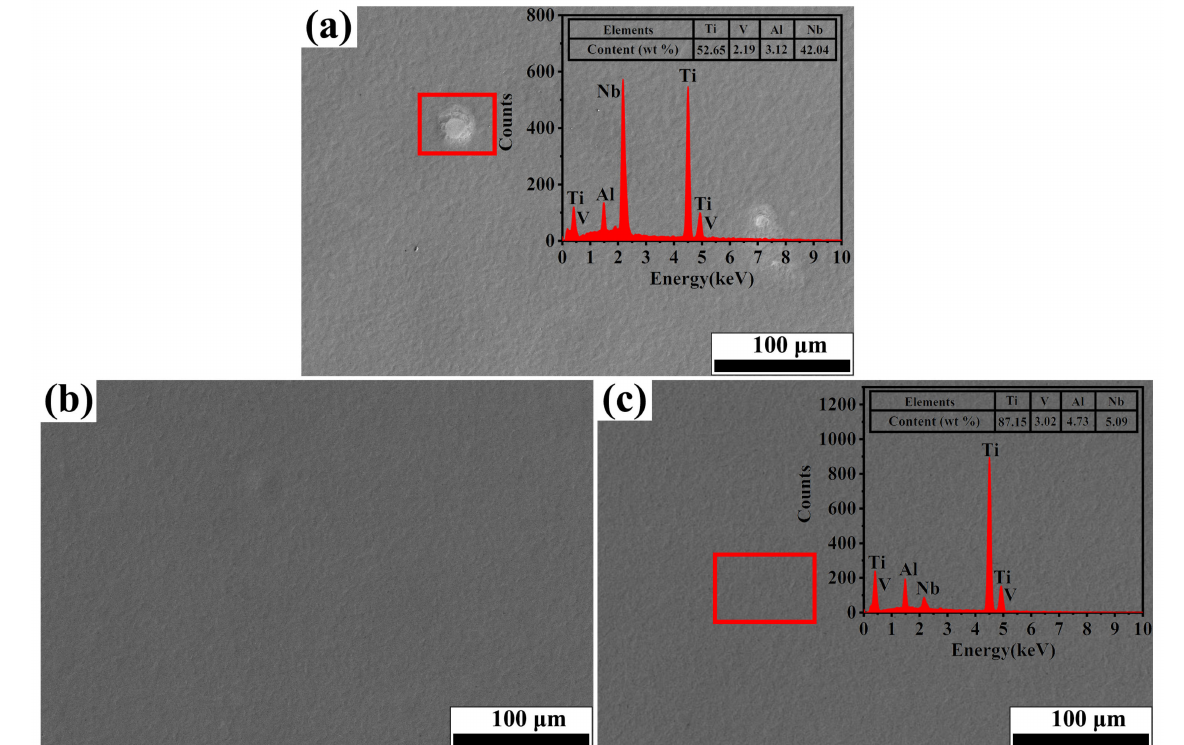
Figure 4. SEM morphology of samples after HCPEB irradiation. ( a ) 20 pulses; ( b ) 30 pulses; ( c ) 40